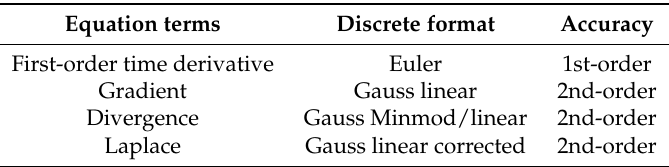
Table 3. Numerical discrete format used in the